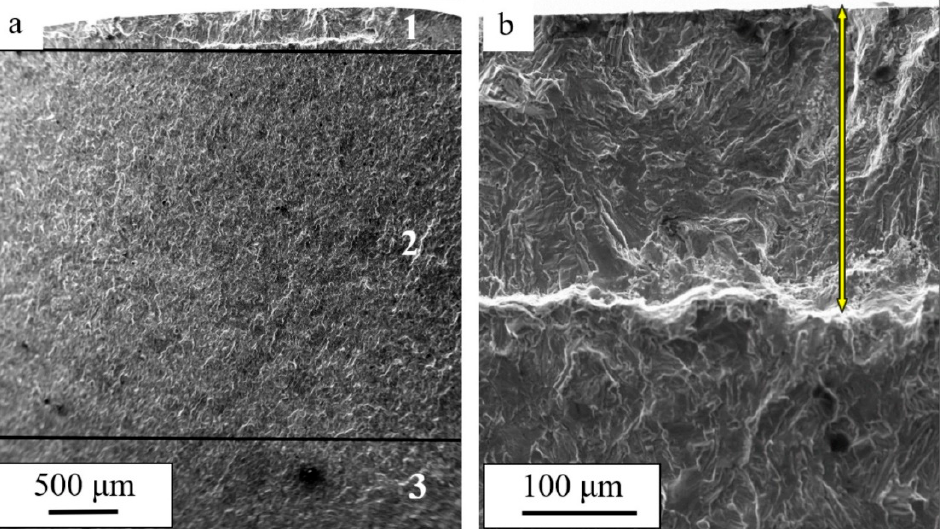
Figure 4. The structure of the fracture surface of a titanium sample subjected to fatigue tests in a magnetic field under B = 0.4 T. In ( a ), the figures indicate the characteristic areas of fatigue destruction: 1—the area of fatigue growth of the fracture; 2—the area of accelerated growth of the fracture; 3—the rupture area. The arrow in ( b ) indicates the area of fatigue growth of the fracture.